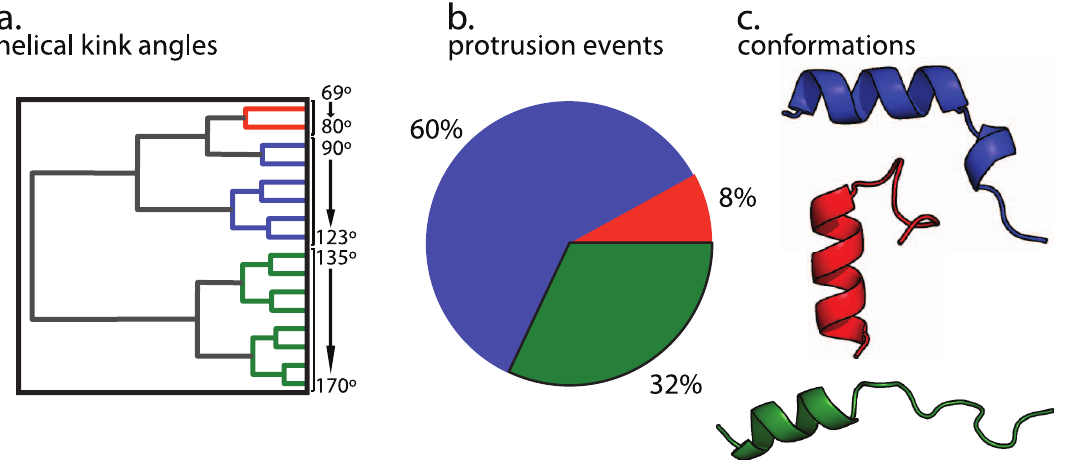
Figure 5. Protrusion events mapped to fusion peptide conformations for the unrestrained X-31 peptide simulation. For each protrusion event, the nearest fusion peptide was selected, and this collection of conformations was clustered by kink angle (a). Peptides were classified as kinked helix (blue), which account for 60% of protrusion events (b), hairpin-like (red), which account for 8% of protrusion events, and relatively flat (green), which account for 32% of protrusion events. Representative structures are rendered in panel (c).